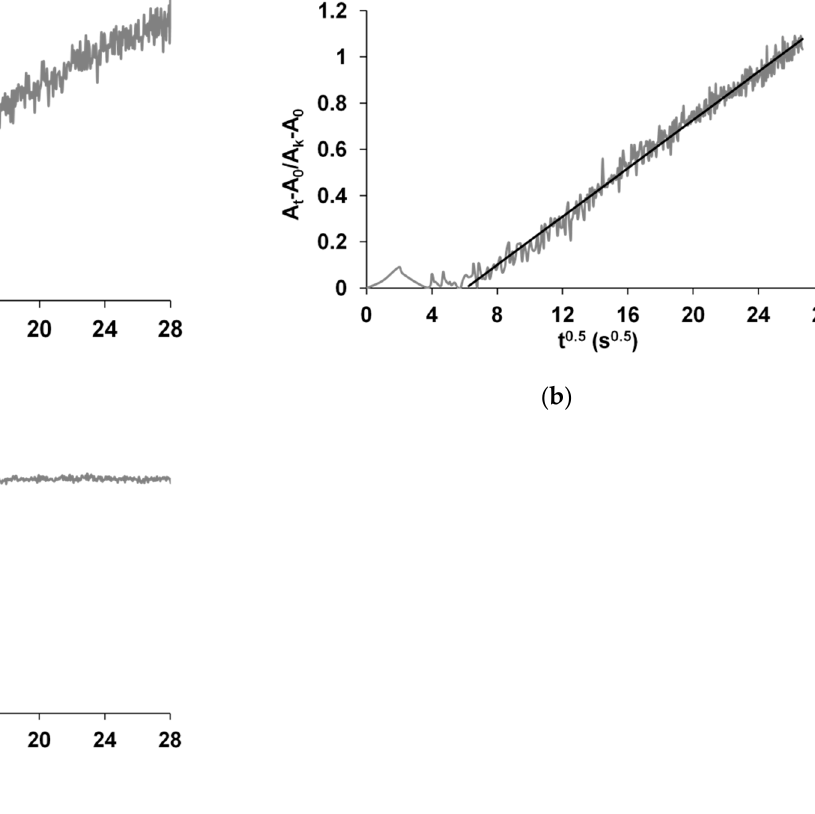
Figure 5. The dependences of (A t − A 0 ) / (A k − A 0 ) on t 0.5 for PEDOT-t-PASA ( a ), PPy-t-PASA ( b ) and PANI-PAMPSA ( c ) at 25 ppm of ammonia. Table 1. Values of the sensor response amplitude ( ∆ A), response time (t r ) and diffusion coefficient (D) at 25 ppm of ammonia and the roughness (R q ) of films electrodeposited in the different mediums. ∆ A at 25 ppm,